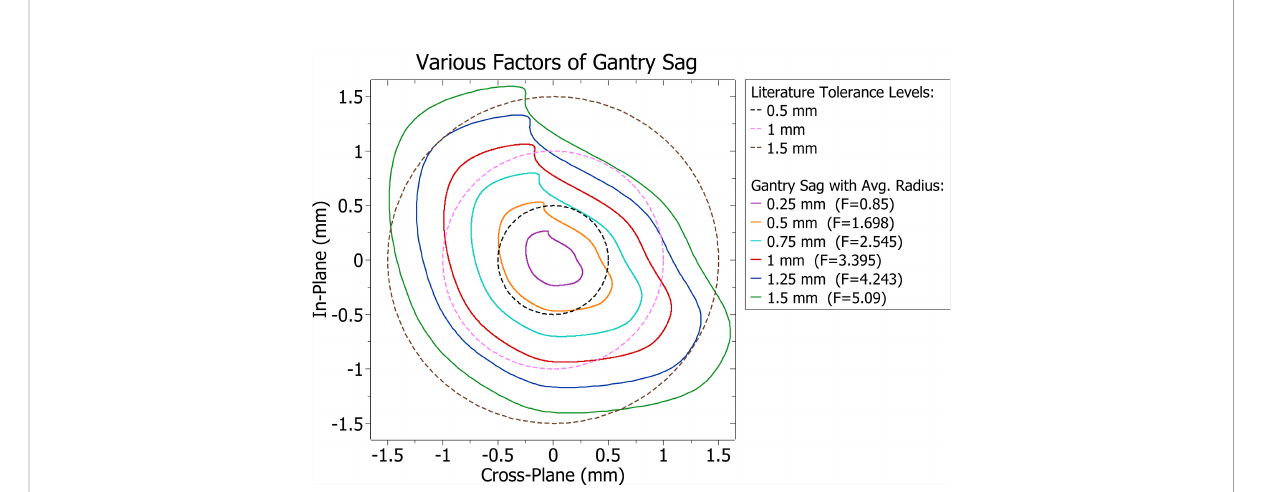
FIGURE 1 Cross-plane and in-plane gantry sag patterns with varying scaling factors